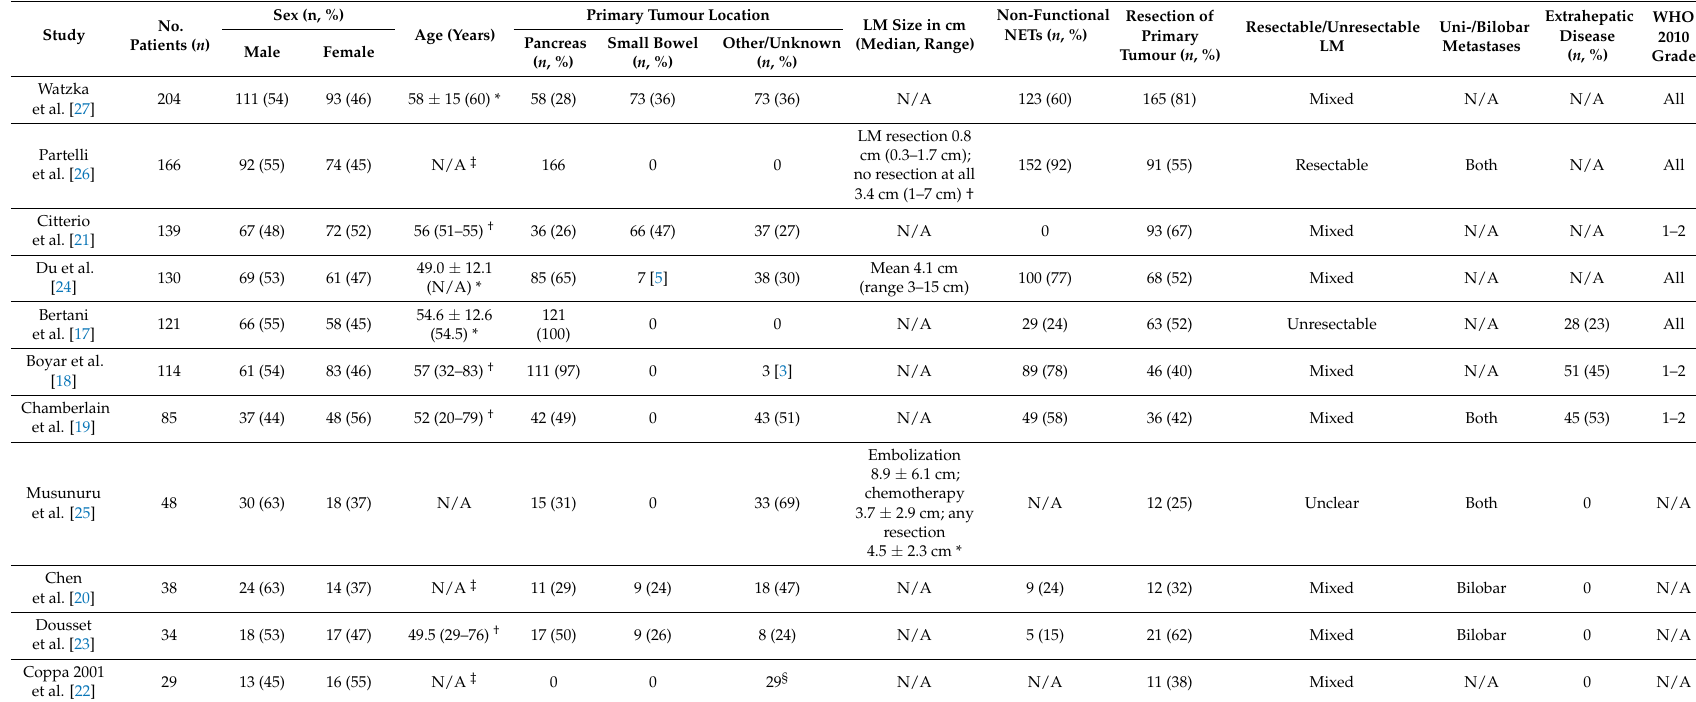
Table 2. Patient characteristics of included